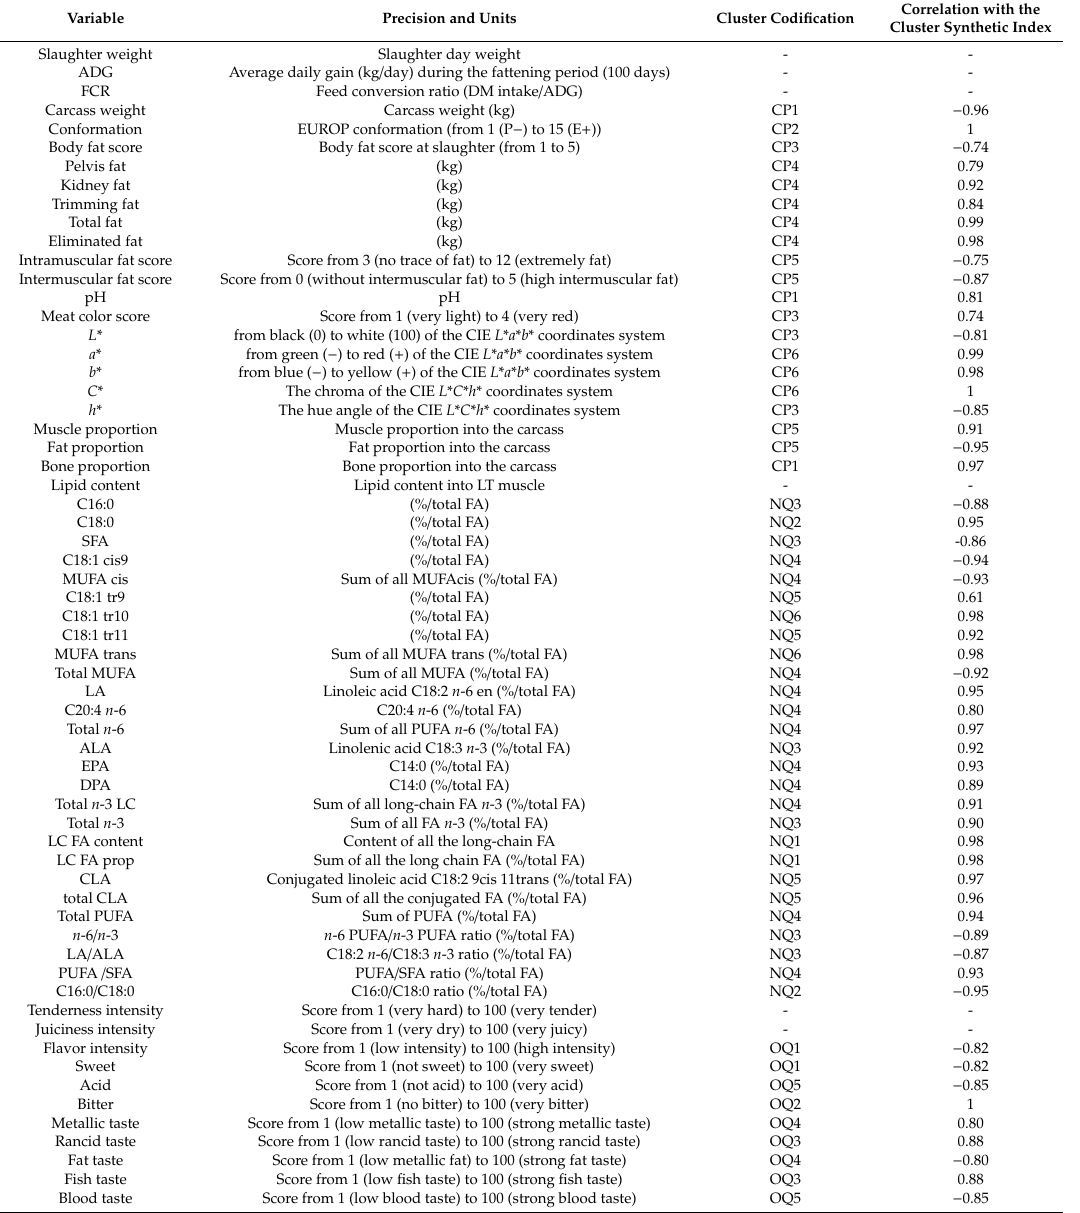
Table A1. Variables in the initial dataset with the clustering assignment and the associated coe ffi cient of correlation between the variables and the synthetic index (calculated as the first component of the principal analysis component (PCA) with all the variables in the